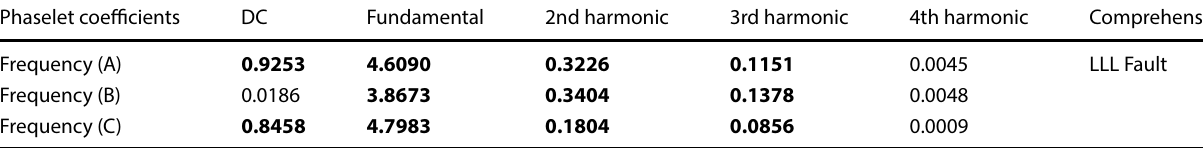
Table 5 Phaselet coefficients under LLL fault